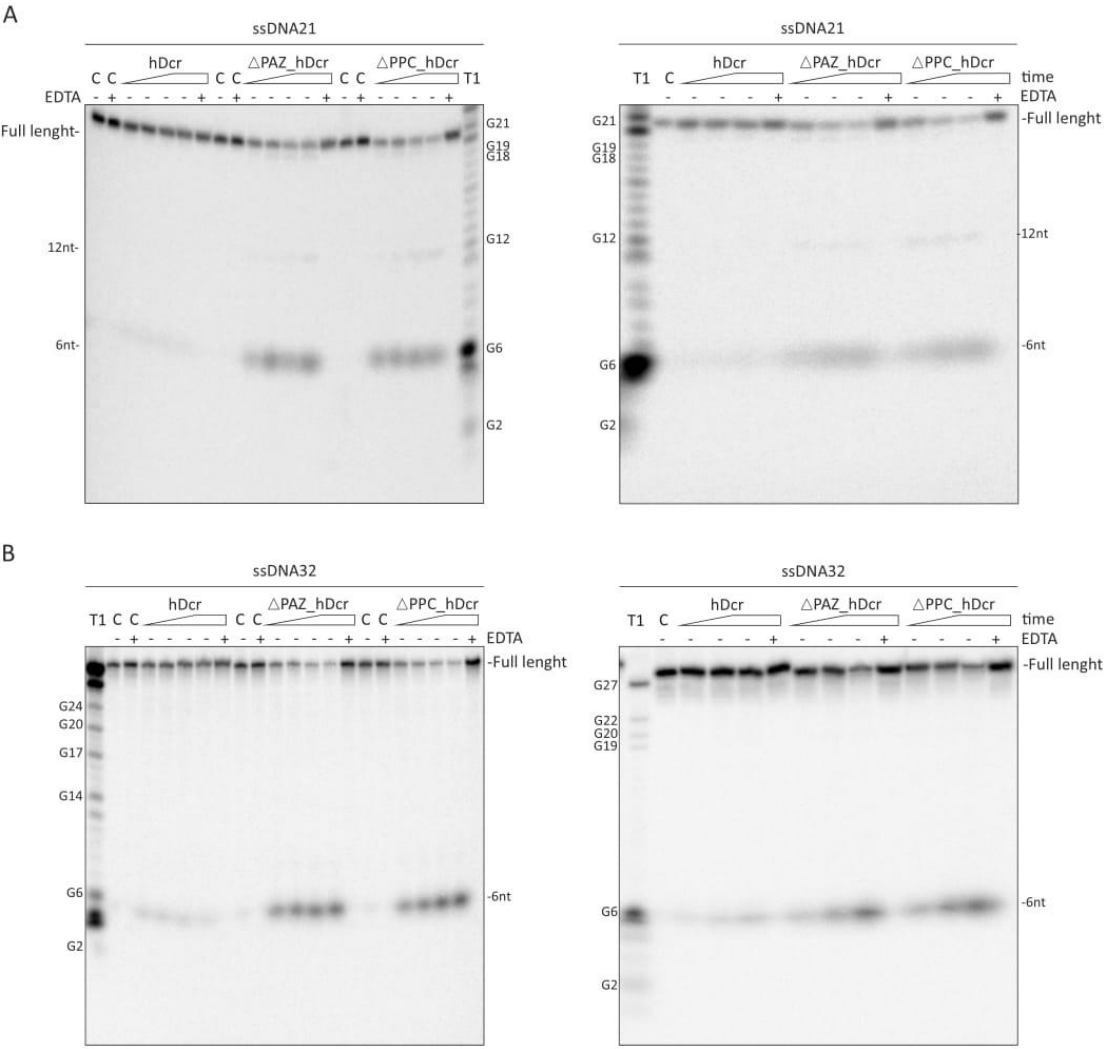
Figure 4. Comparison of the DNase activity of full-length hDicer (hDcr) and the PAZ domain deletion variants ΔPAZ_hDcr and ΔPPC_hDcr on short ssDNA substrates. (A, B; left panels) The results of the DNA-cleavage assays involving: 21-nt ssDNA (A; left panel) and 32-nt ssDNA (B; left panel) , and increasing amounts of the respective protein (hDcr, ΔPAZ_hDcr or ΔPPC_hDcr): 12.5, 25, 50, 75 nM (represented by a triangle). (A, B; right panels) The results of the time-dependent cleavage of 21-nt ssDNA (A; right panel) and 32-nt ssDNA (B; right panel). Triangles represent time points: 15 min, 30 min, 1h. Reactions were carried out with 50 nM protein (hDcr, ΔPAZ_hDcr or ΔPPC_hDcr). ( C- ) controls incubated without a protein. ( C+EDTA ) controls incubated without a protein but with 25 mM EDTA. ( +EDTA ) supplementation of the reaction buffer with 25 mM EDTA. (T1) G-ladder generated with RNase T1.